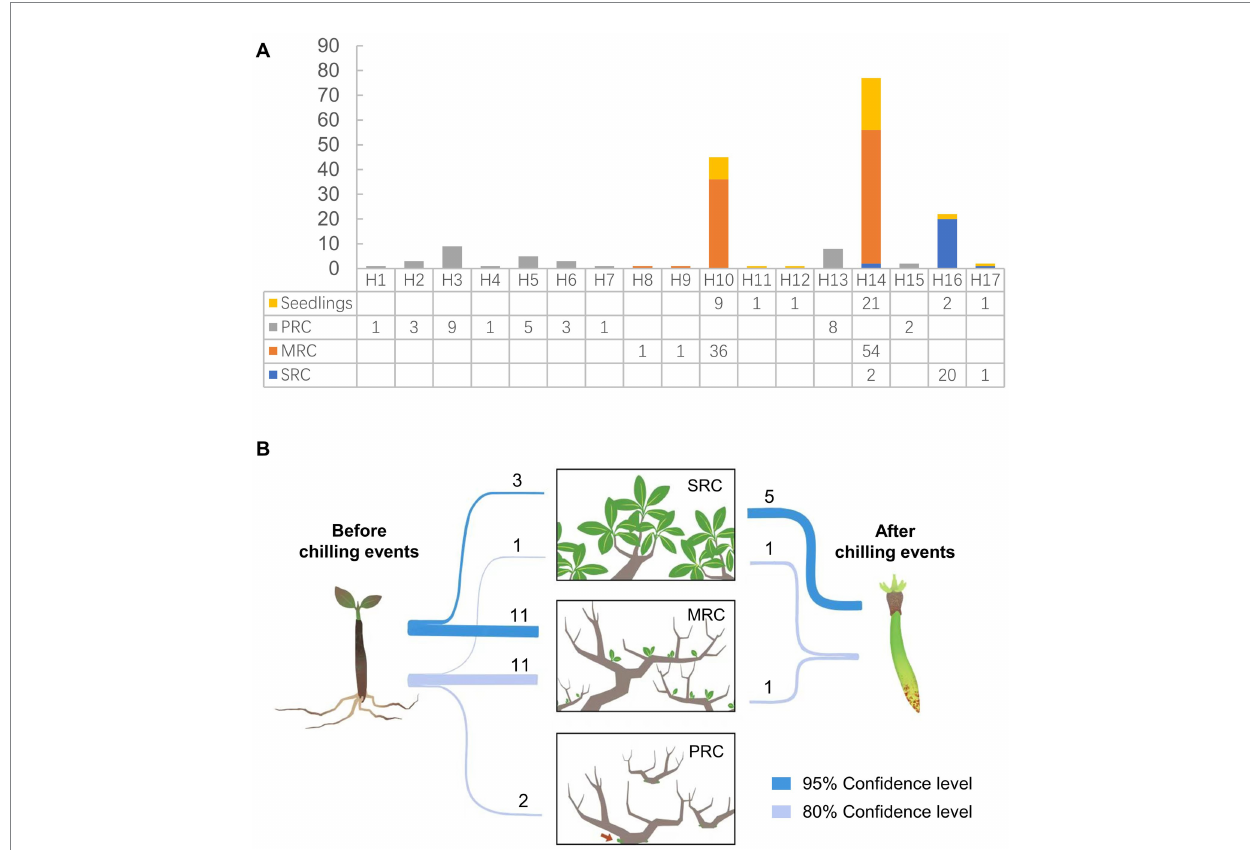
FIGURE 3 (A) Distribution of plastid haplotypes among seedlings and three phenotypic groups in the Yueqing population of Kandelia obovata . (B) Assignment of potential parents of seedlings and propagules among the three phenotypic groups. SRC: group with strong resistance to cold; MRC: group with moderate resistance to cold; and PRC: group with poor resistance to cold.